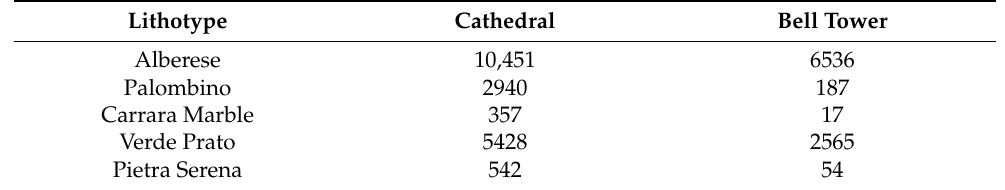
Table 1. Quoins number and stone